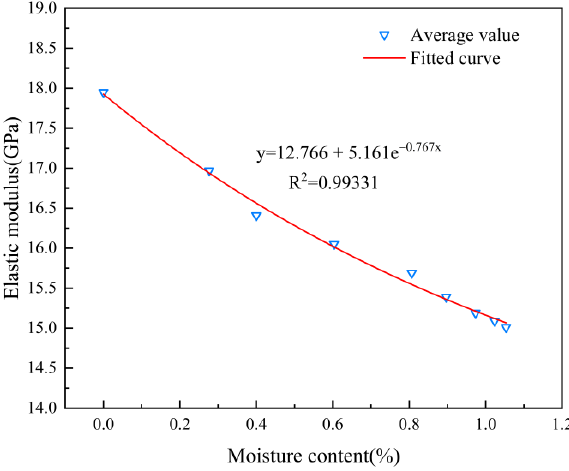
Figure 6. Relationship between elastic modulus and moisture content.